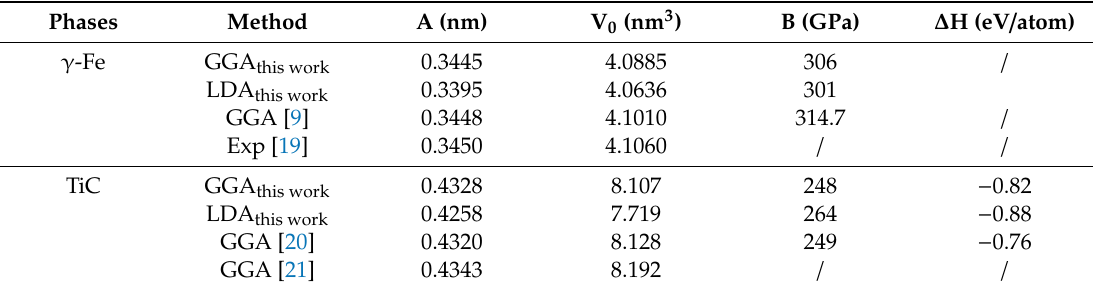
Table 1. Calculated lattice constants (a), volume (V 0 ), bulk modulus (B), and formation enthalpy ( ∆ H) of bulk γ -Fe and